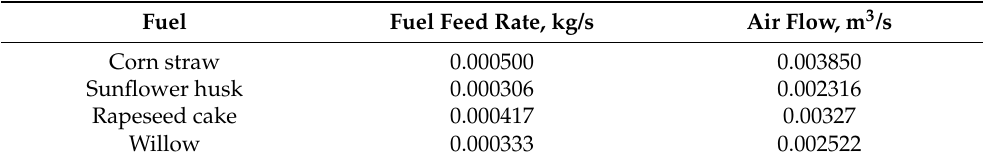
Table 1. Comparison of fuel feed rate and air flow during combustion of straw, sunflower husk, rapeseed cake, and willow pellets.